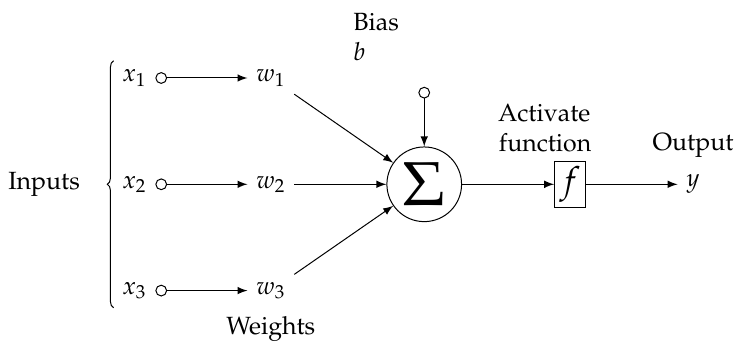
Figure 3. Neuron